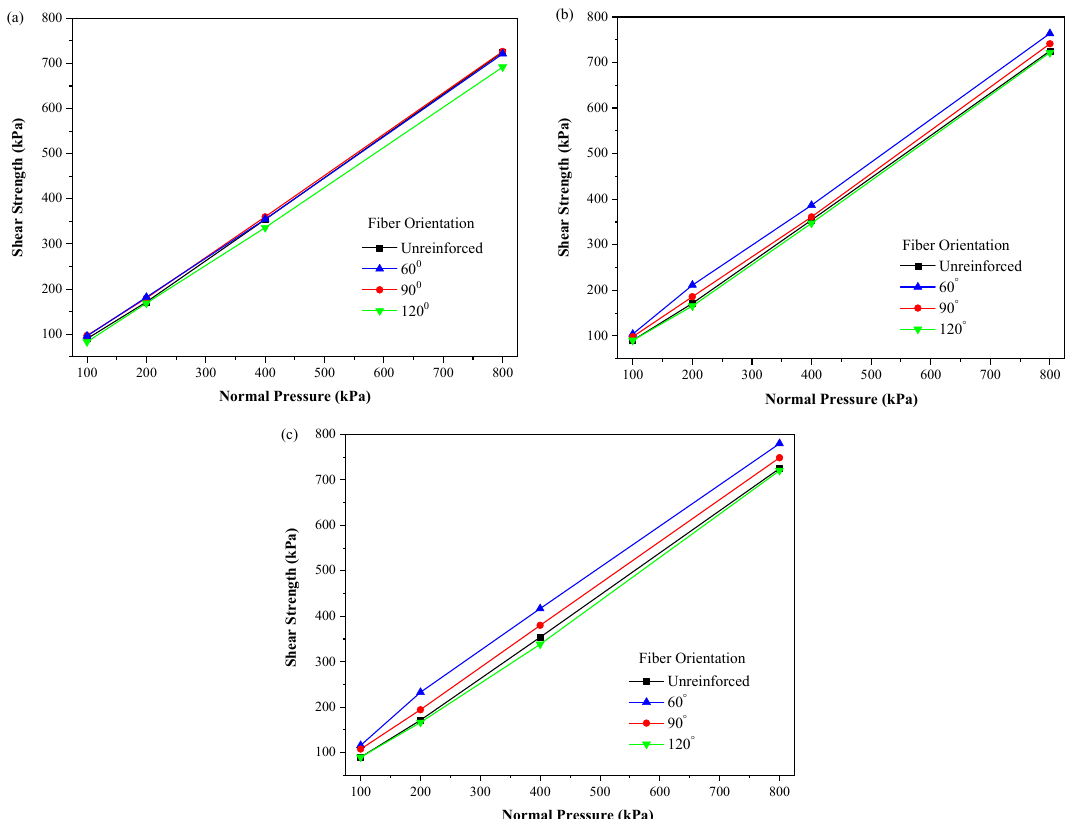
Figure 4. Shear strength envelope of reinforced sand with fiber contents of ( a ) 0.04%, ( b ) 0.2%, and ( c ) 0.4%.